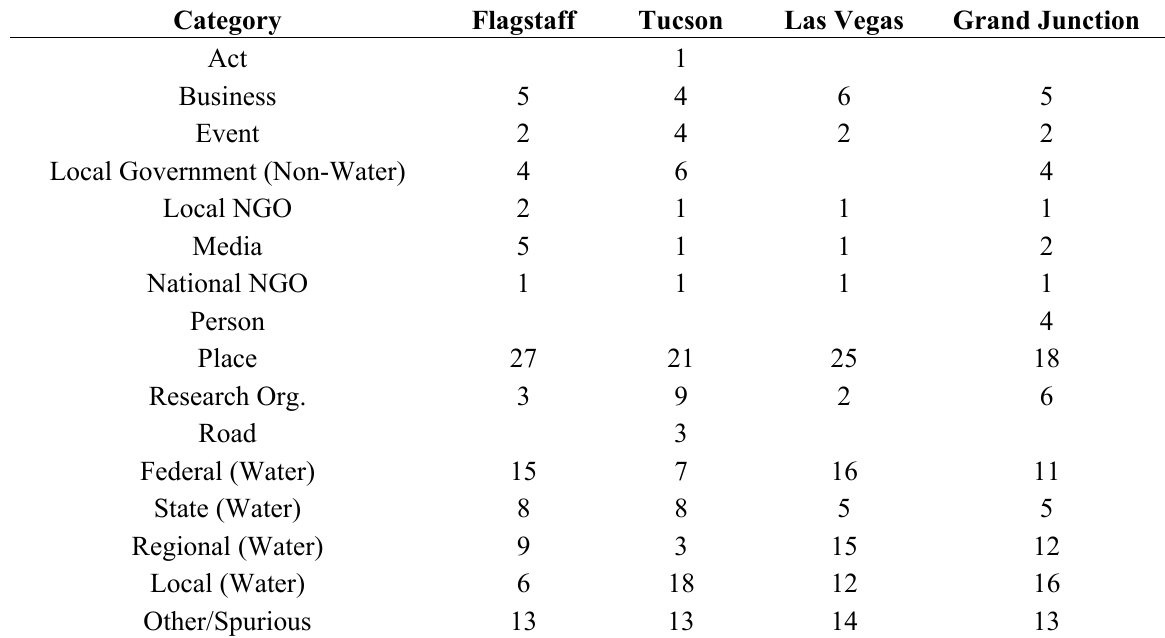
Table 8. Counts of entities by category in the Top 50 after Step 1 of the analysis. Category Flagstaff Tucson Las Vegas Grand Junction Act 1 Business 5 4 6 5 Event 2 4 2 2 Local Government (Non-Water) 4 6 4 Local NGO 2 1 1 1 Media 5 National NGO 1 Person 4 Place 27 21 25 18 Research Org. 3 9 2 6 Road 3 Federal (Water) 15 State (Water) Regional (Water) Local (Water) 16 Other/Spurious 13 13 14